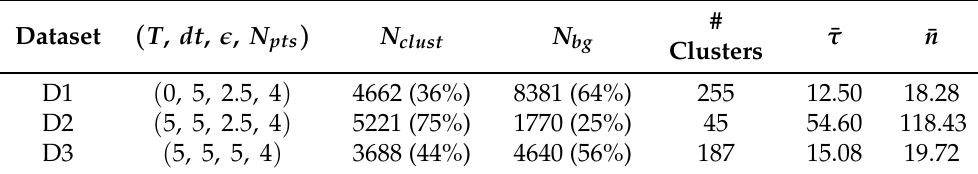
Table 4. Cluster statistics and the parameter set of the clustering algorithm for the three datasets. N clust corresponds to the number of clustered events and N bg to the background seismicity frequency. ¯ τ and ¯ n are the mean duration in days and size of the clusters, respectively.